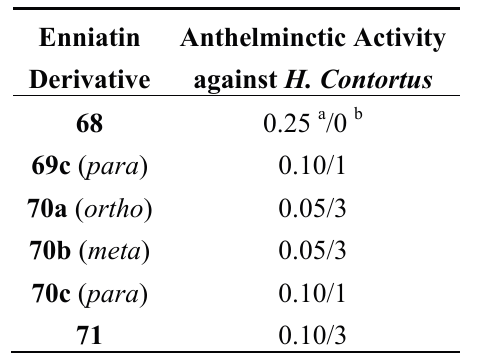
Table 2. Anthelmintic activity of enniatin derivatives 68 – 71